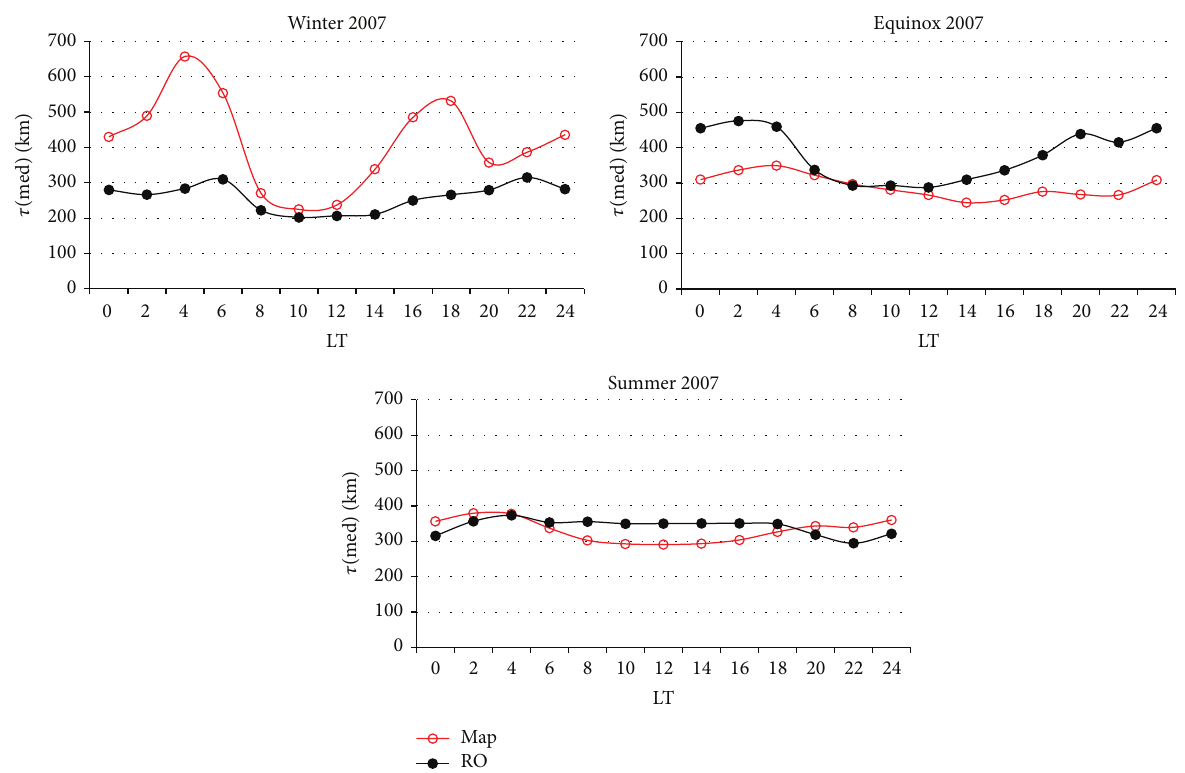
Figure 10: Comparison of 𝜏 according to radio occultation measurements and averaging the values of global maps for specific stations and three